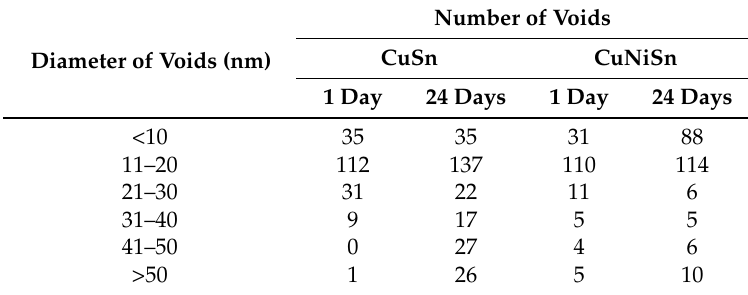
Table 1. Number of voids vs. diameter of voids in Cu/Sn and Cu/Ni/Sn aged at room temperature for 24